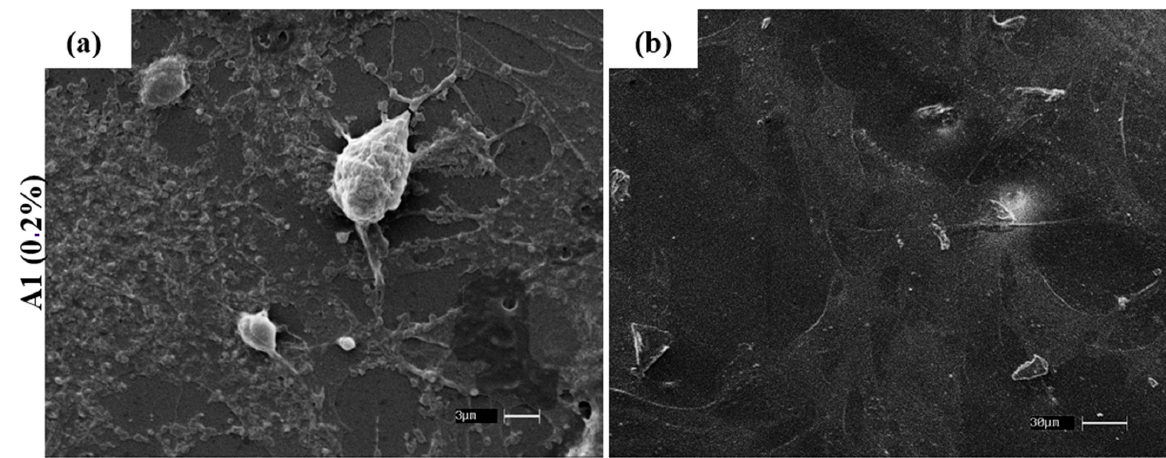
Figure 8. SEM analysis, showing the canine MSCs from dental pulp and adipose tissue attached to the nanocomposites (PLLA-GO) after 7 days culture. Bars: 3 µm ( a ) and 30 µm ( b ).